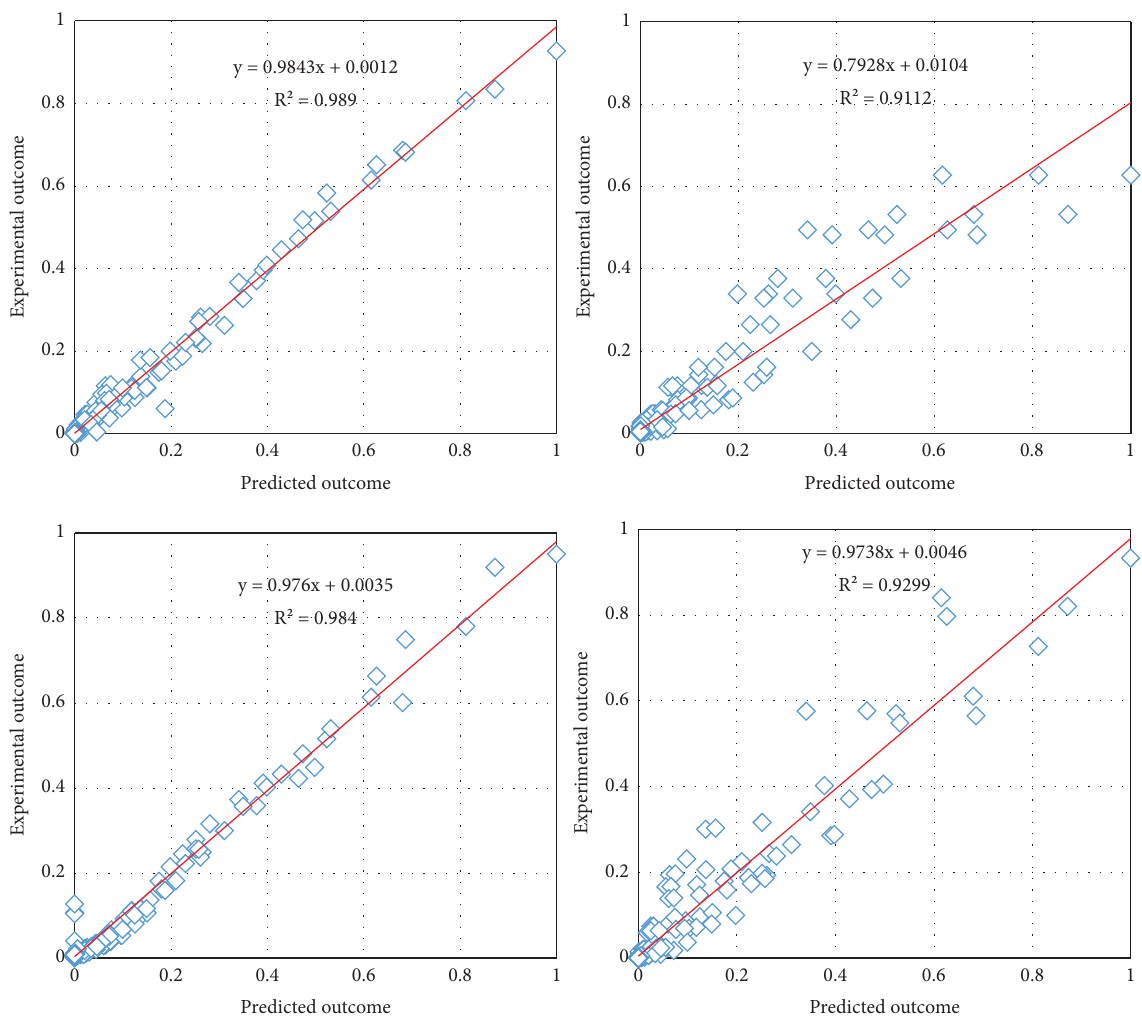
Figure 10: Te measures of goodness of ft for (a) ANN G ∗ prediction, (b) ANN δ prediction and SVM, (c) SVM G ∗ prediction, and (d) SVM δ prediction model results. Table 2: ANN and SVM model results for G ∗ and δ